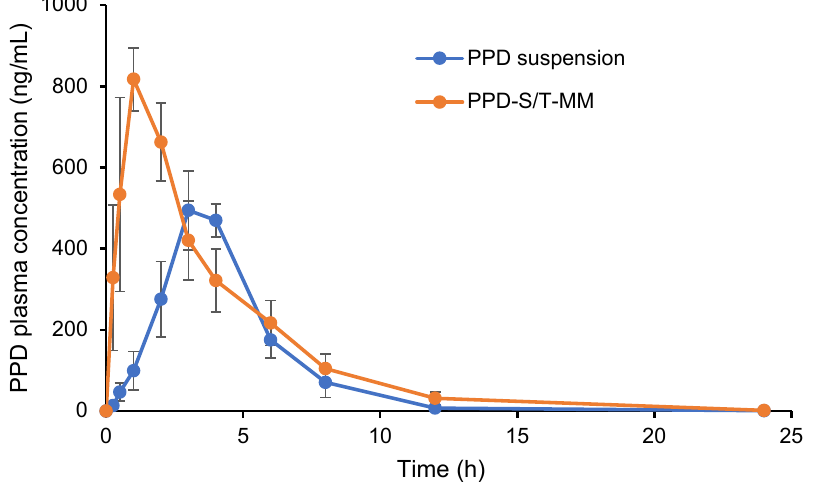
Figure 9. Mean plasma concentration-time profiles of PPD after intragastric administration of PPD-S/T-MM or PPD suspension in rats (mean ± SD, n = 3). Table 6. Pharmacokinetic parameters of PPD after intragastric administration of PPD-S/T-MM or PPD suspension in rats (mean ± SD, n = 3).